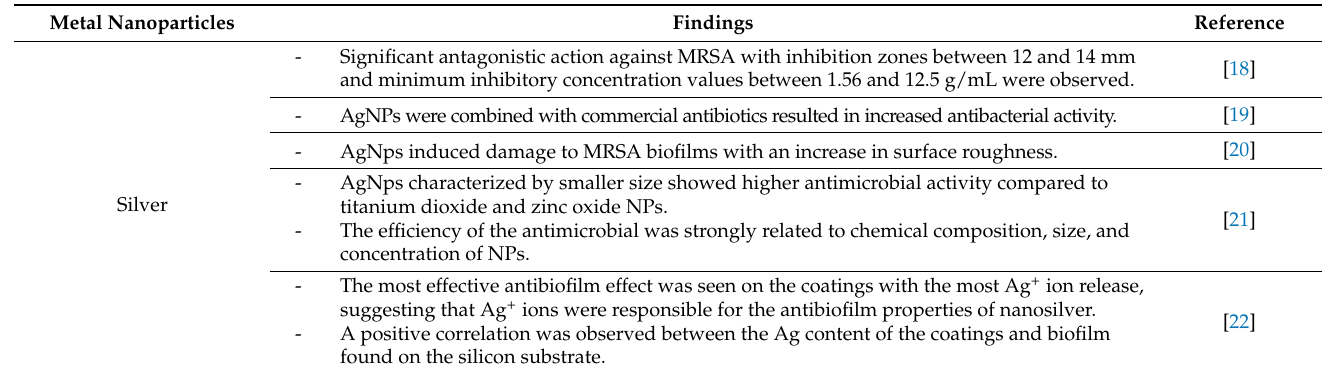
Table 1. Summary of metal NP discussed in the present